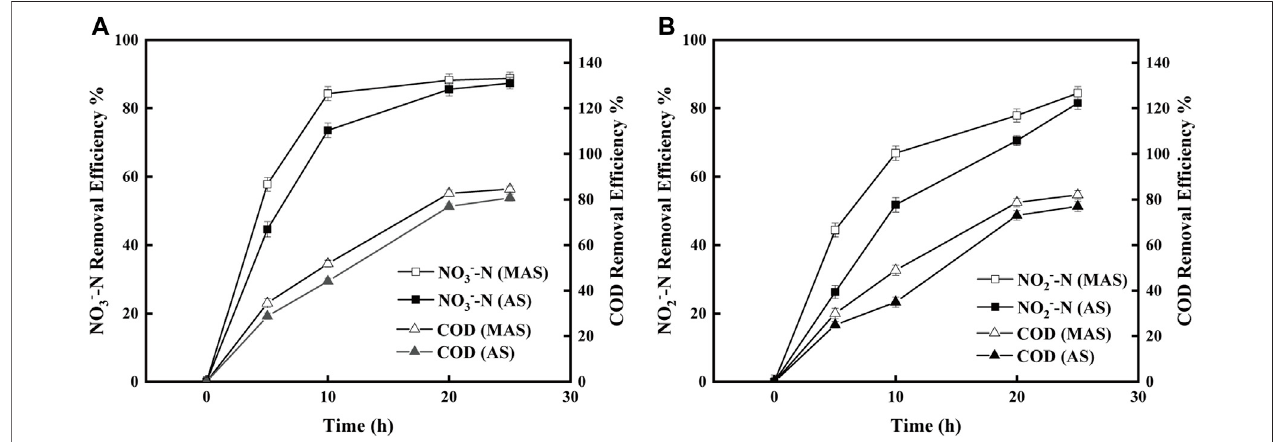
FIGURE 6 | Time course of COD changes in MAS and AS reactors under different denitri fi cation substrates [ (A) NO 3 − -N and (B) NO 2 − -N].